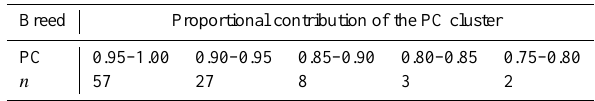
Table 4. Proportional contribution of the PC cluster. Breed Proportional contribution of the PC cluster